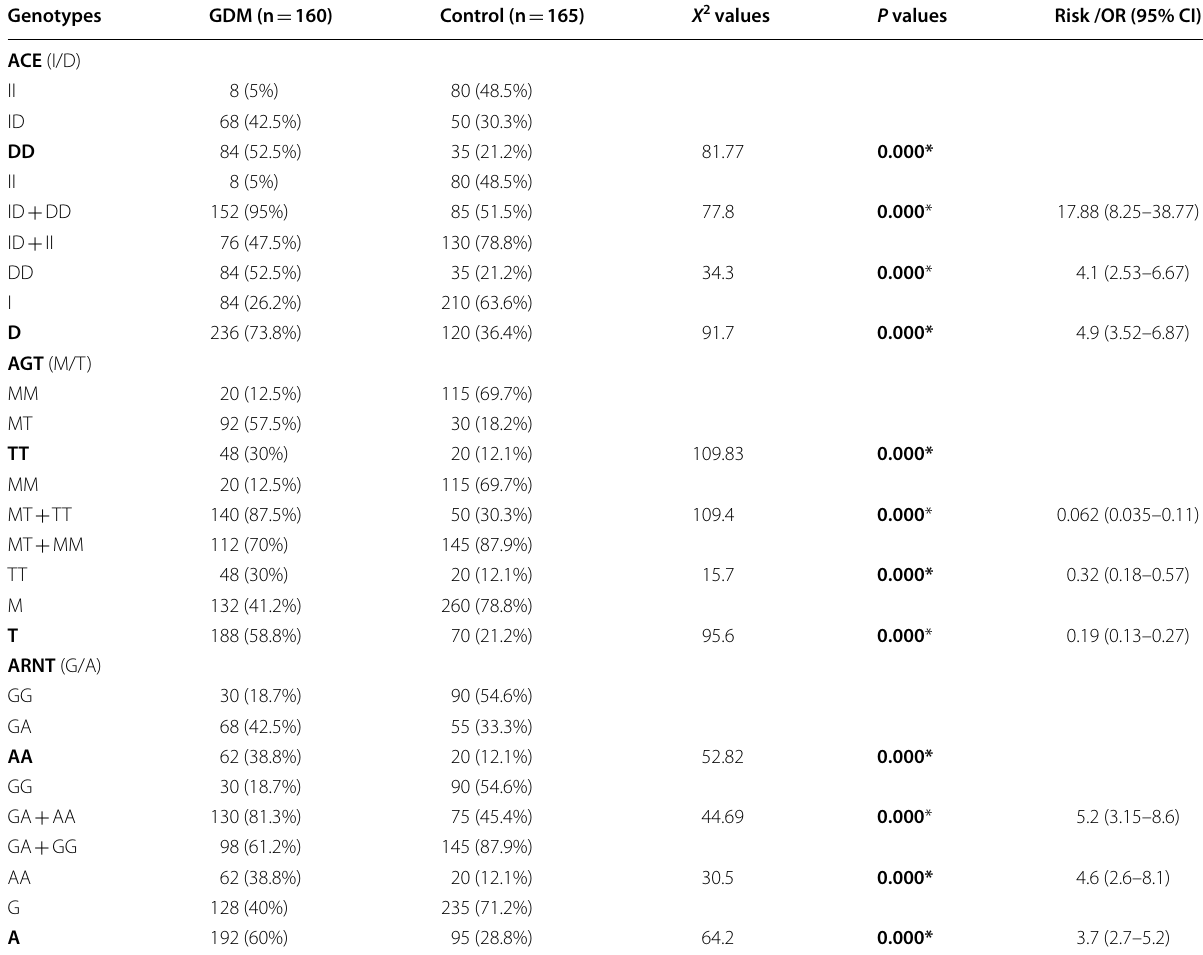
Table 1 Genotype distribution of ACE, AGT, and ARNT genes polymorphisms in the studied